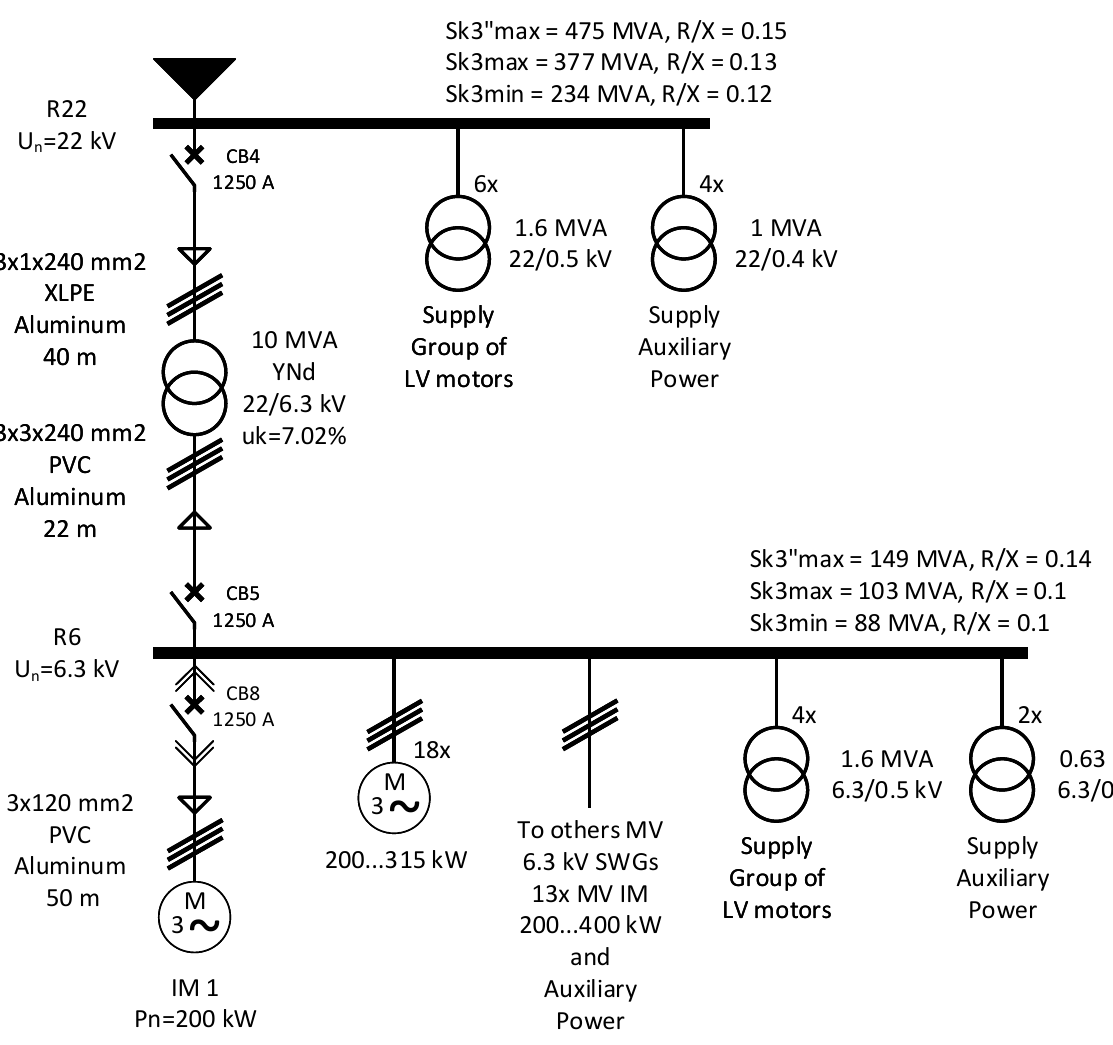
Figure 5. Simplified single-line diagram of the distribution system.